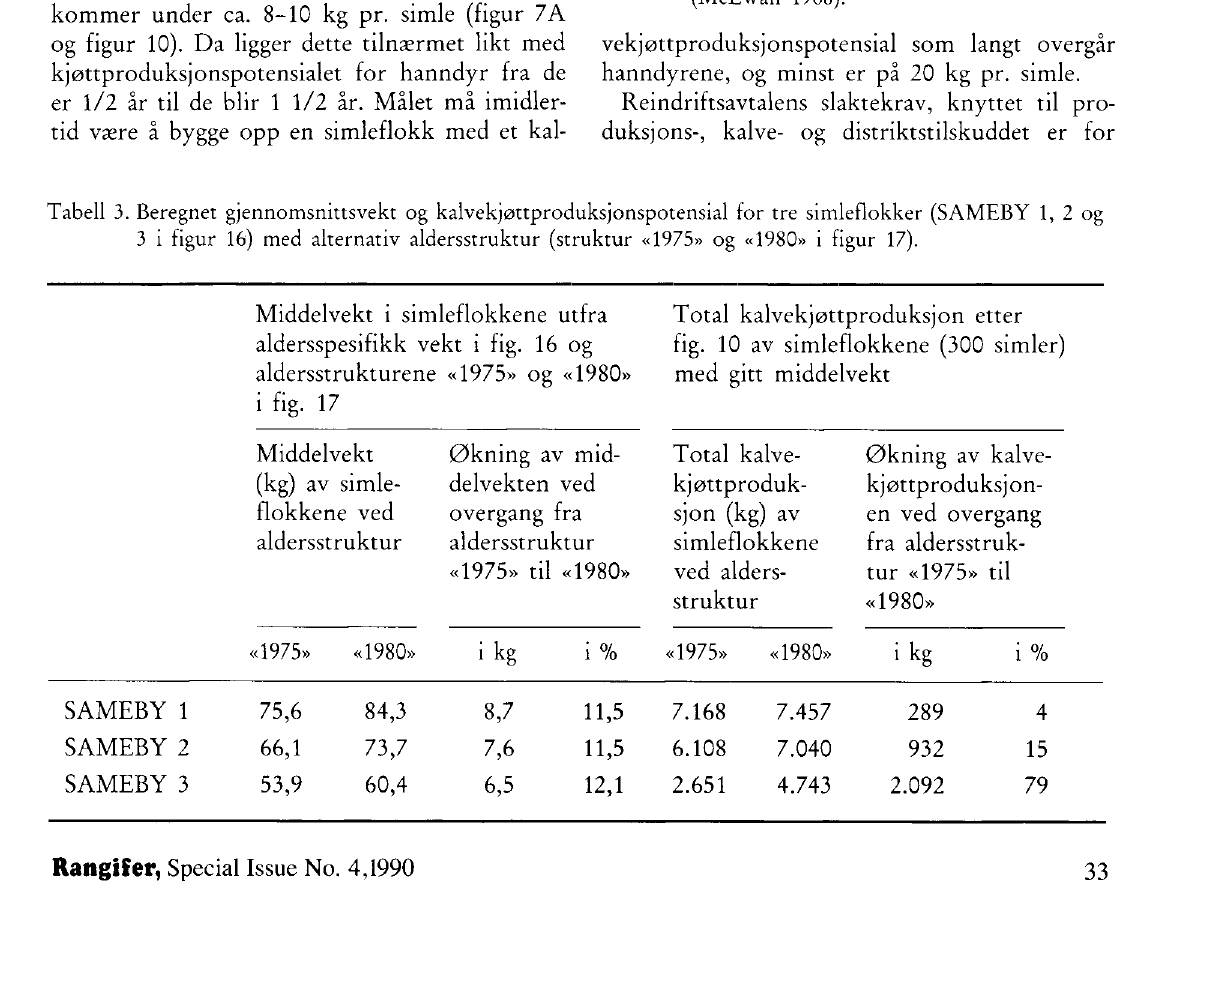
Figur 18. Kjøttproduksjon (fettlagring ikke medreg net) på bukker i forhold til alder og ernæ ring. «Foret» er uten restriktiv ernæring, mens «Beiting» er med restriktiv ernæring (McEwan 1968). vekjøttproduksjonspotensial som langt overgår hanndyrene, og minst er på 20 kg pr. simle. Reindriftsavtalens slaktekrav, knyttet til pro duksjons-, kalve- og distriktstilskuddet er for